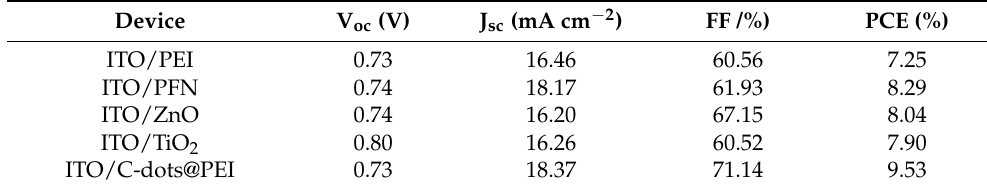
Table 2. Photovoltaic (PV) parameters of the devices with different electron transport layers